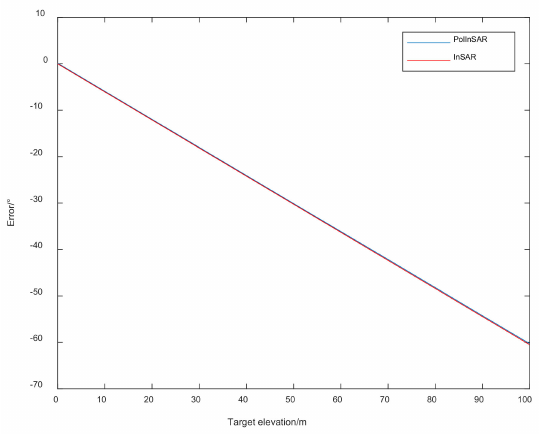
Figure 8. Influence of MCRE on InSAR and